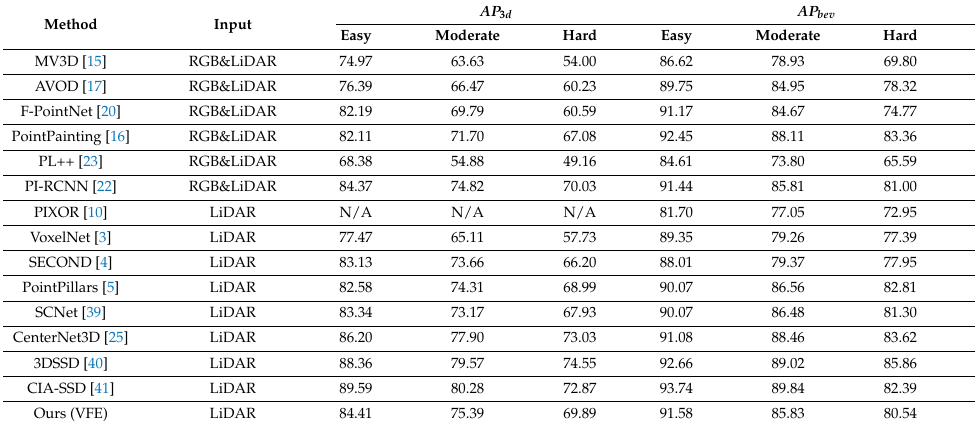
Table 3. Comparison to the state-of-the-art methods. We set IoU to 0.7 for AP 3 d and AP bev results on the KITTI test set for Car